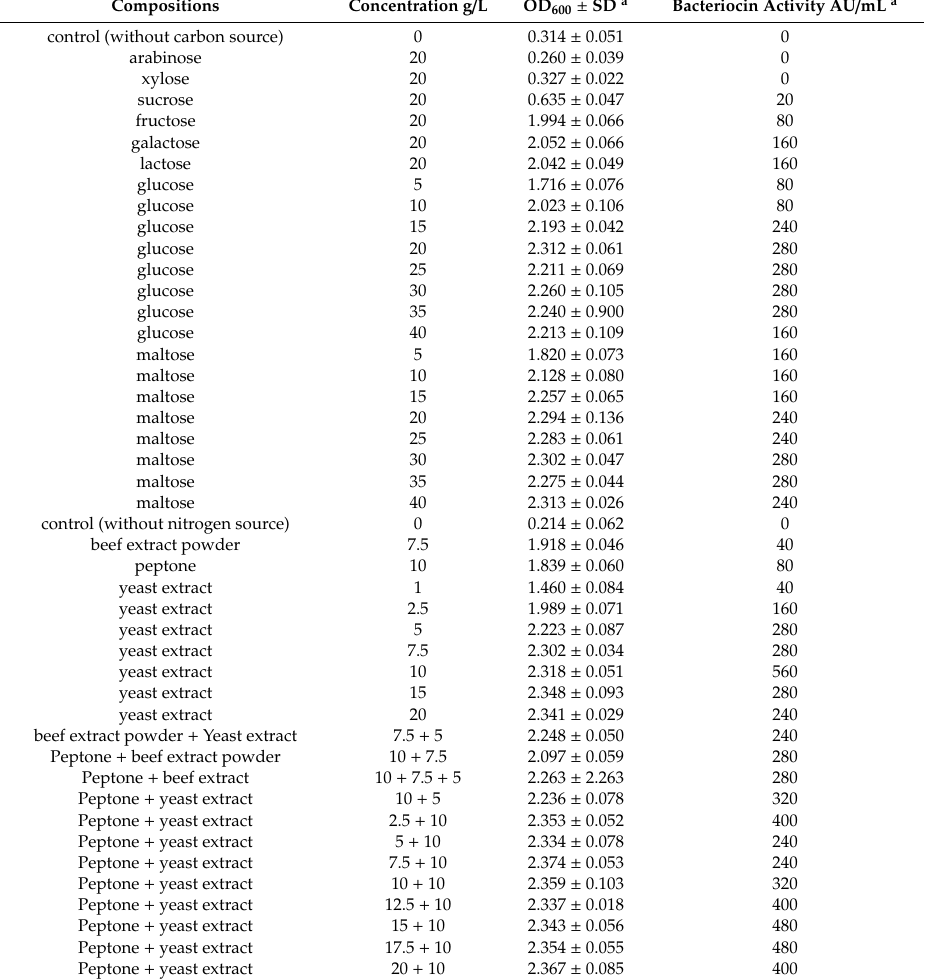
Table 1. Influences of the carbon source and nitrogen source on bacteriocin Lac-B23 production and bacterial